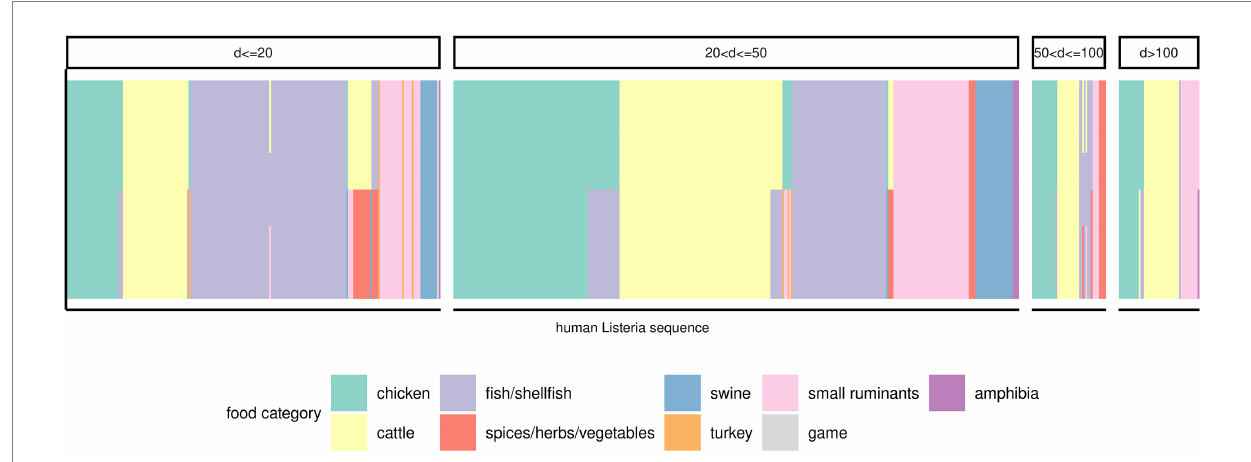
FIGURE 5 Potential food sources for the sporadic human Lm isolates. One vertical bar corresponds to a human Lm sequence ( x -axis). The color of the bars is indicative of the food category the respective human Lm sequence was most similar with (i.e., smallest distance). Bars containing multiple colors indicate that two or three food categories were equally distanced from the human Lm sequence. The various panels indicate the range of distances between the respective human Lm sequences and the matching food